Question: Identify the chart type used in this figure.
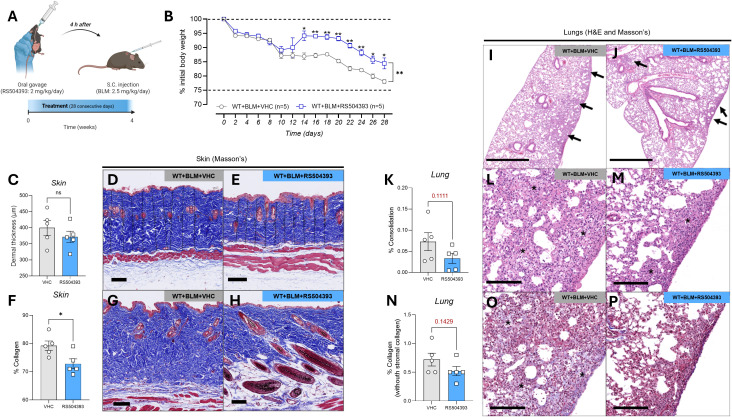
Answer: line